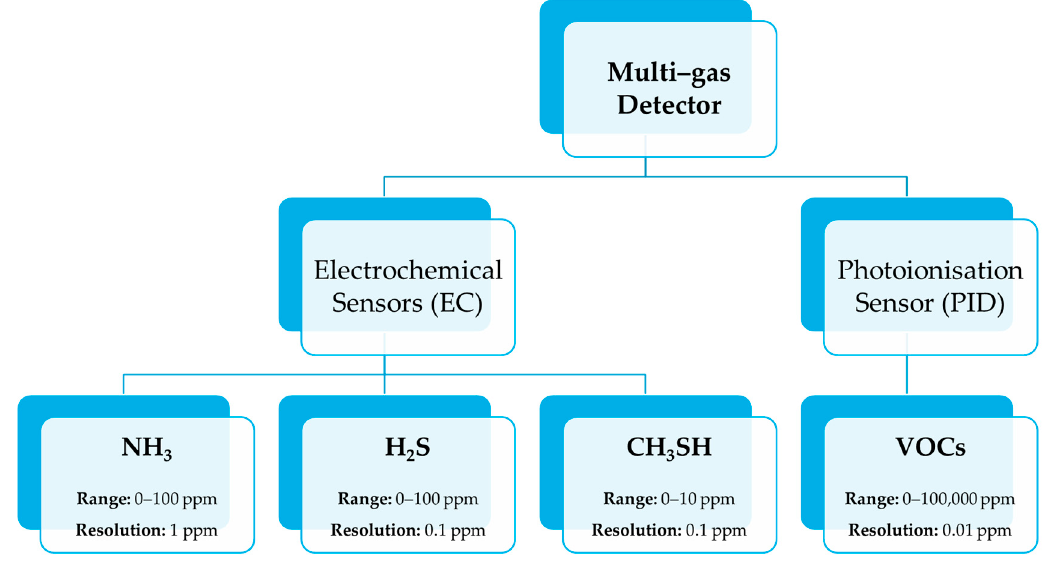
Figure 2. The MultiRae Pro gas detector characteristic. Table 1. Measurement points at the examined biogas plants.